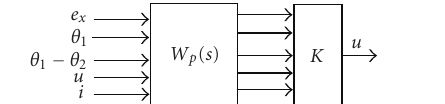
Figure 4: The H ∞ loop-shaping controller K with specification function.